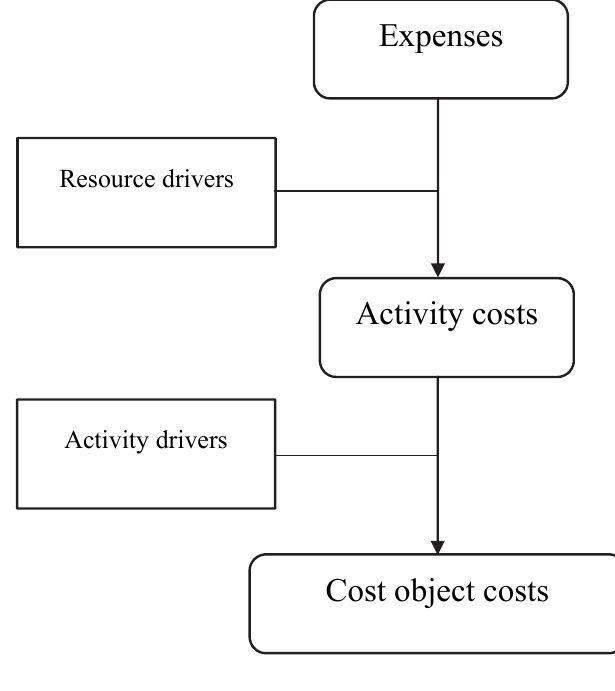
Fig. 1. The structure of